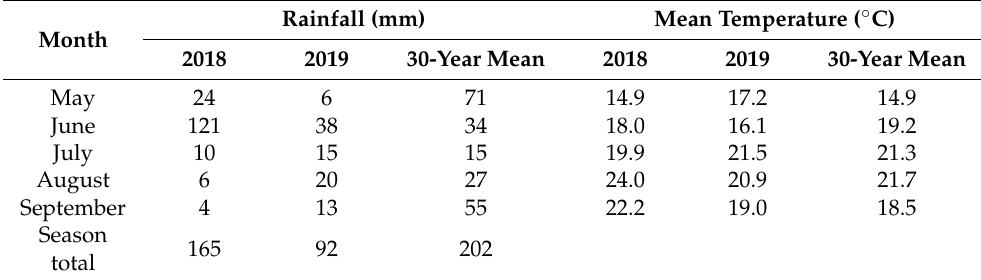
Table 1. Average monthly weather conditions during the experiment (2018–2019) and the 30-year mean